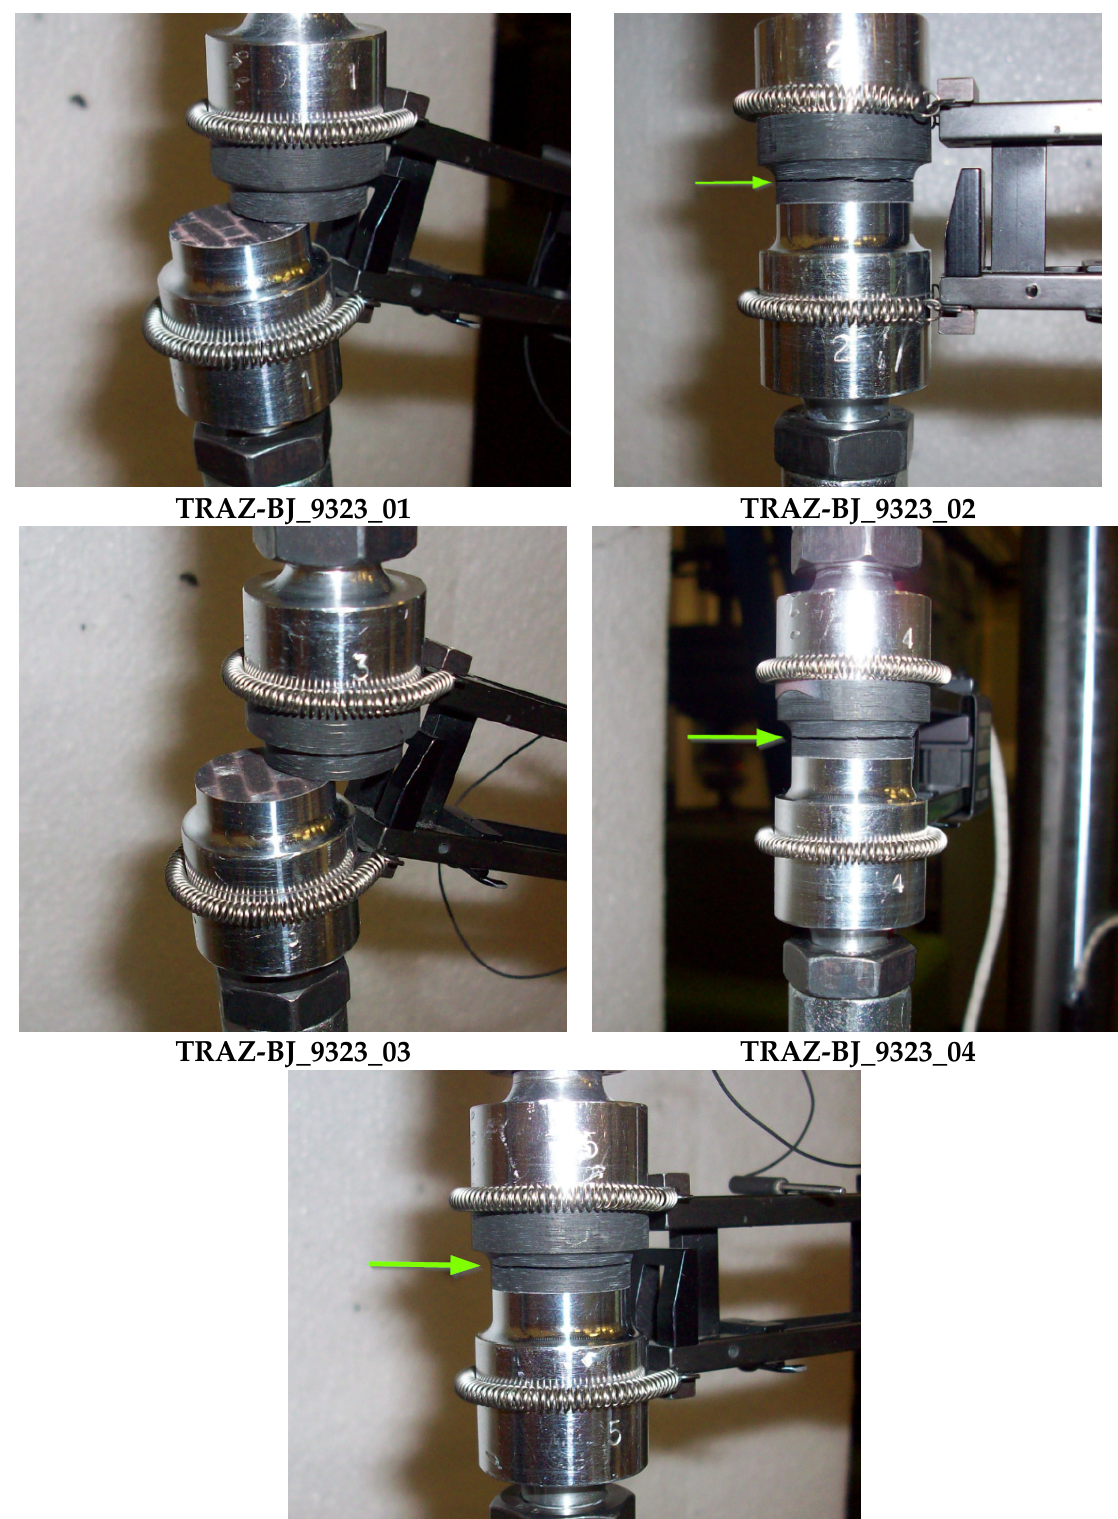
Figure 13. Highlight of failure location in TRAZ-BJ_9323 tests. The red arrow points out the failure section.